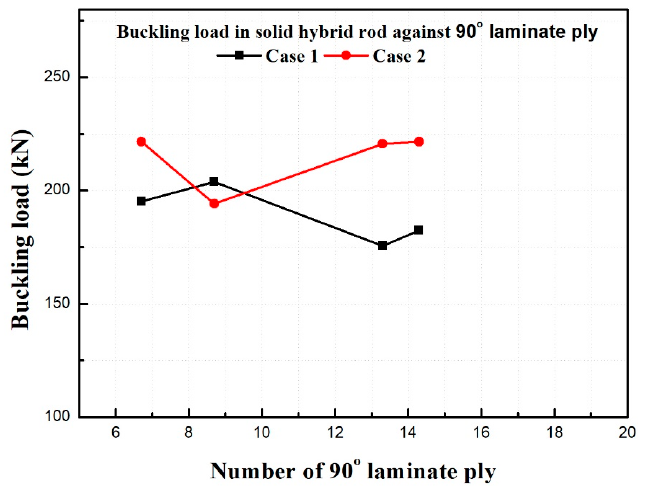
Figure 14. Variation of buckling load with respect to 90° ply laminate in CFRP.